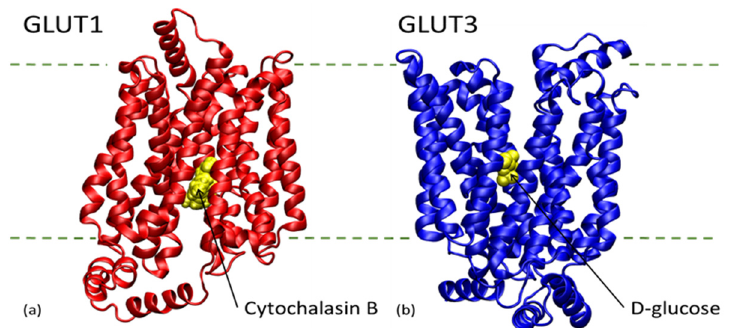
Figure 2. ( a ) Structure of GLUT1 in complex with cytochalasin B, according to the crystal structure 5EQI [173]. ( b ) Structure of GLUT3 in complex with D-glucose according to the crystal structure 4ZW9 [176]. The ligands cytochalasin B ( a ) and D-glucose ( b ) are represented with yellow van der Waals spheres.